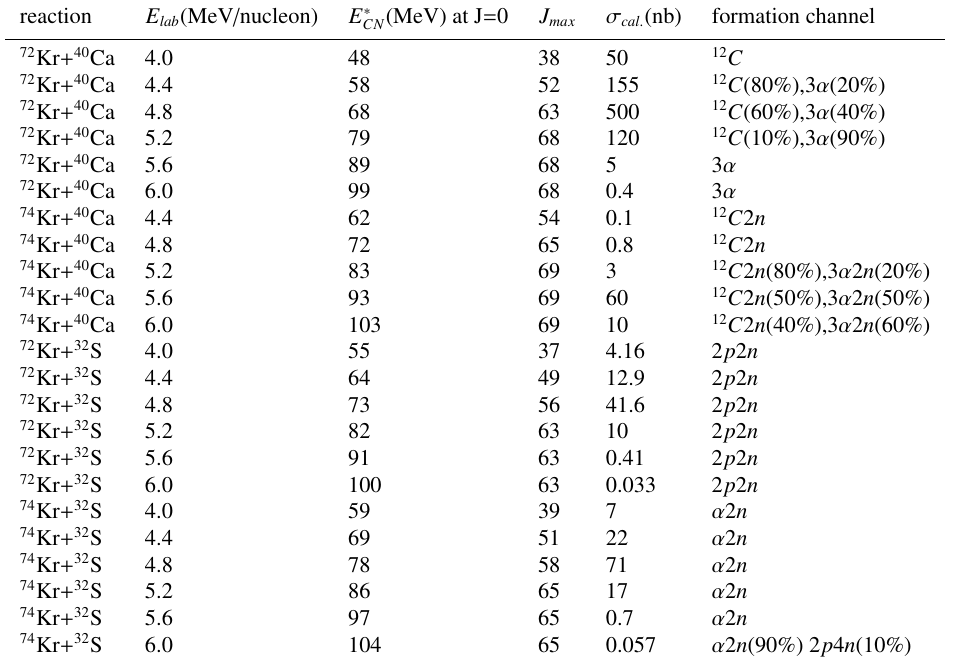
Table 2. Calculated weights of formation channels and production cross sections for 100 Sn.